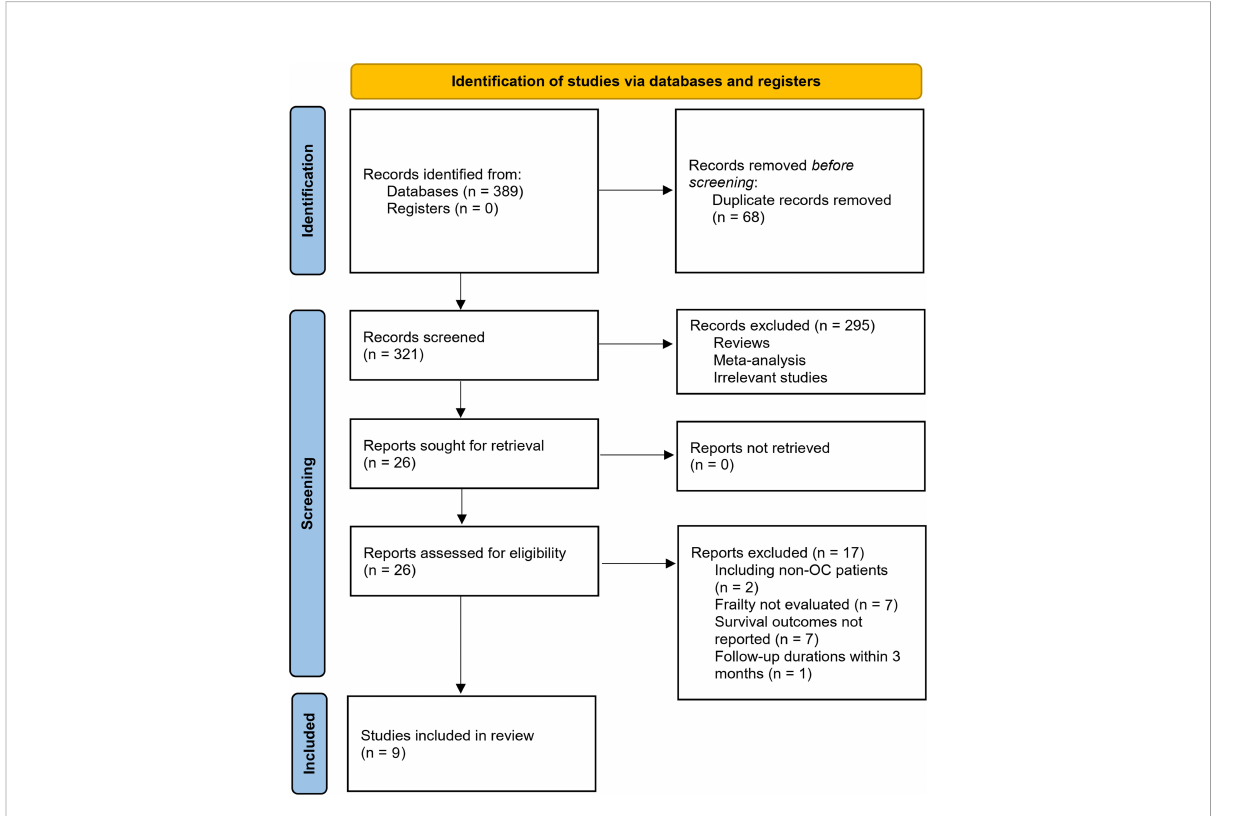
FIGURE 1 Summarized process of literature search and study identi fi